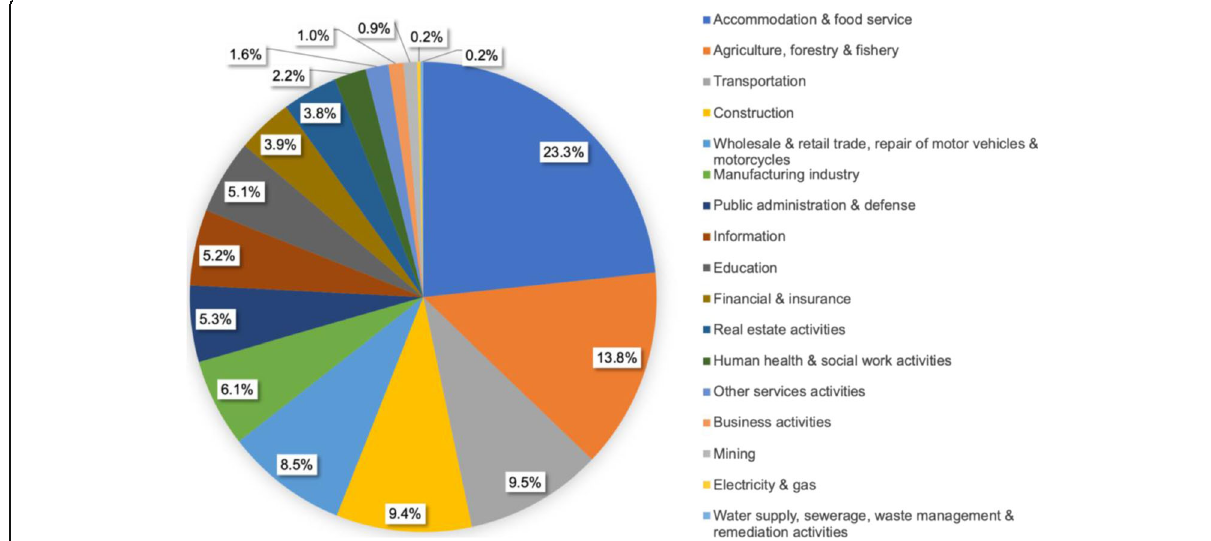
Fig. 2 Sectoral distribution of the gross regional domestic product (GRDP) of Bali, 2018